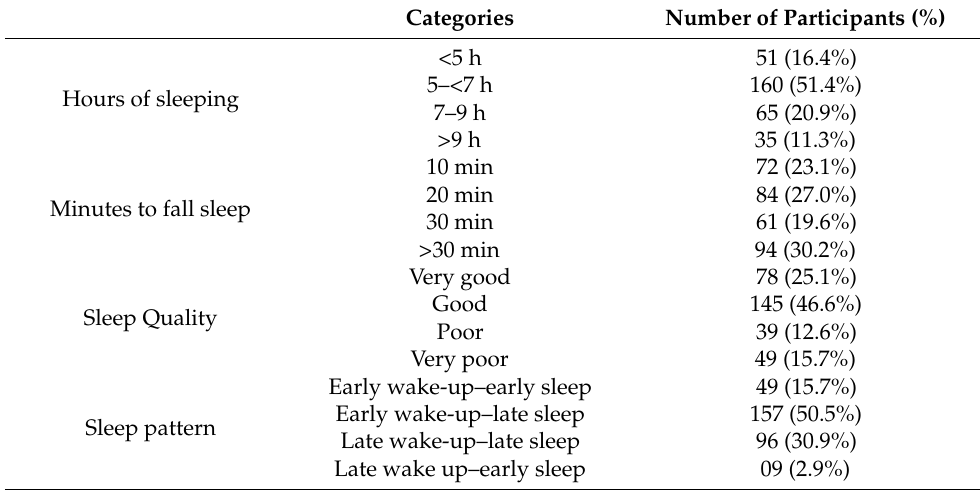
Table 2. Participants’ sleep characteristics.